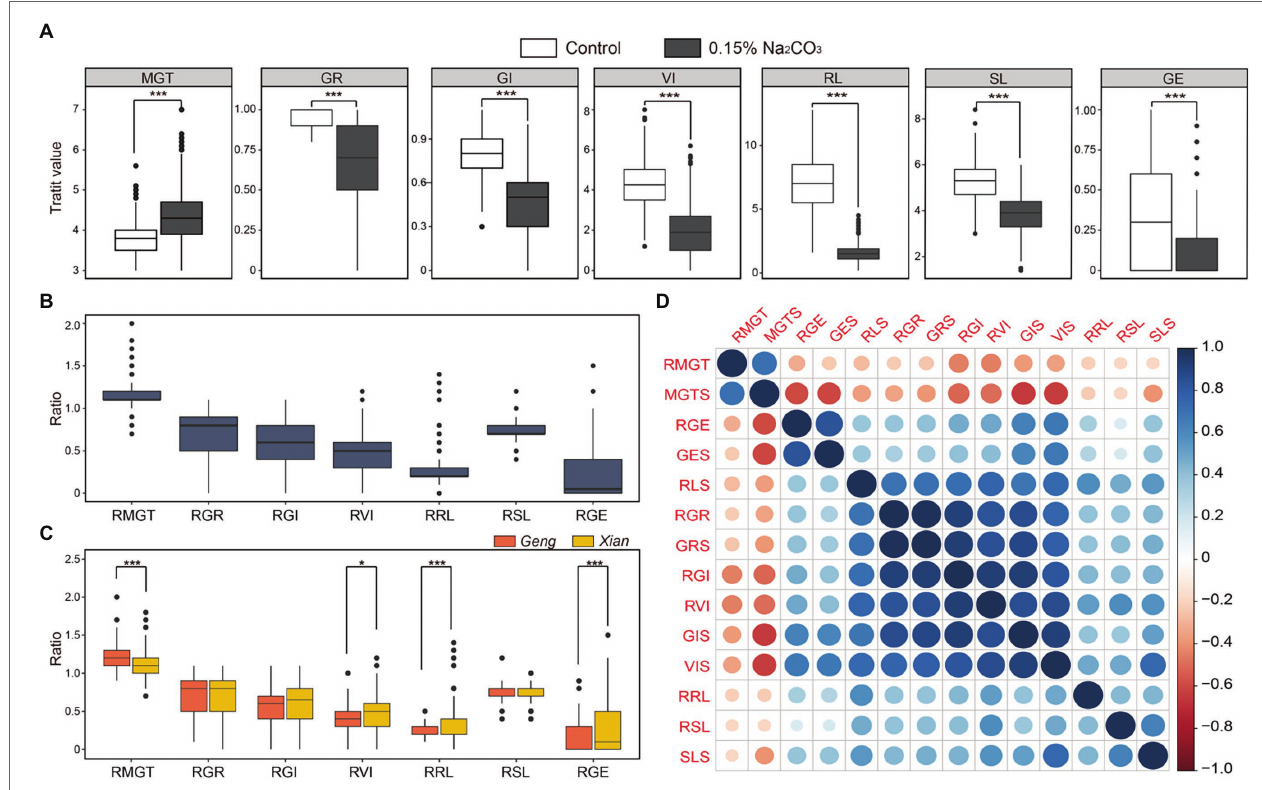
FIGURE 1 | Phenotypic variations of germination-related traits under alkali stress and control conditions. (A) Distribution of mean germination time (MGT), germination rate (GR), germination index (GI), vigor index (VI), root length (RL), shoot length (SL), and germination energy (GE) under control and alkali stress (0.15% Na 2 CO 3 ). Distribution of relative alkali damage of measured traits in the whole population (B) , Xian and Geng subpopulations (C) . (D) Correlation coefficient of alkali tolerance-related traits in the whole population. * and *** indicate significant difference at p < 0.05 and p < 0.001 (two-tailed Student’s t -test) in (A,C) ,